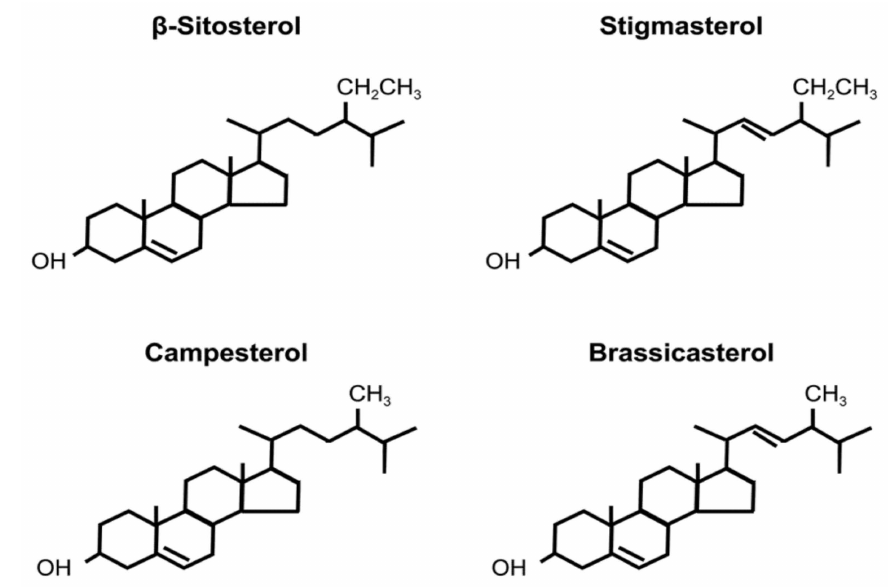
Figure 1. Structure of